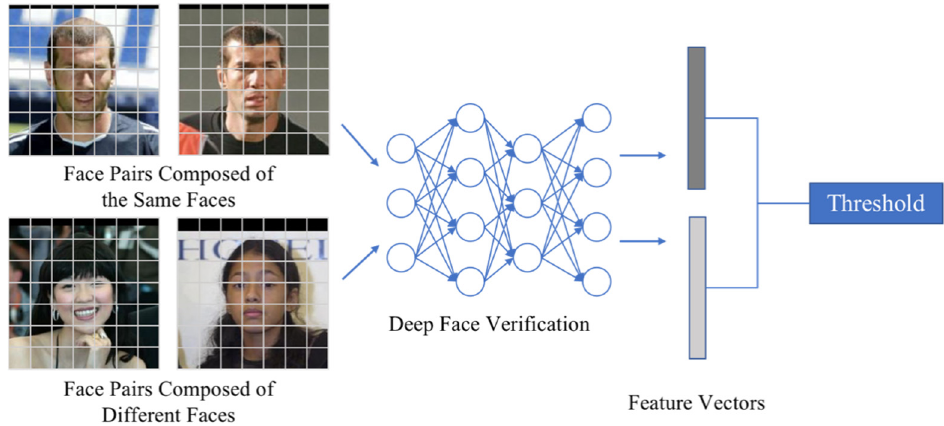
Figure 3. Schematic diagram of the face feature vector and threshold comparison.